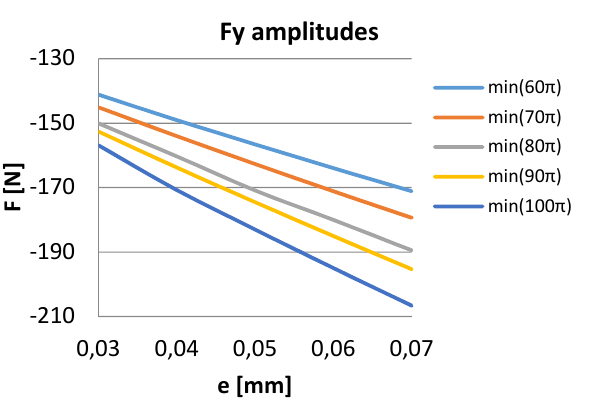
Fig. 12. Fy negative amplitudes Values of force amplitudes as function of amplitude of deviation are displayed in Fig. 9. – 12. Values of